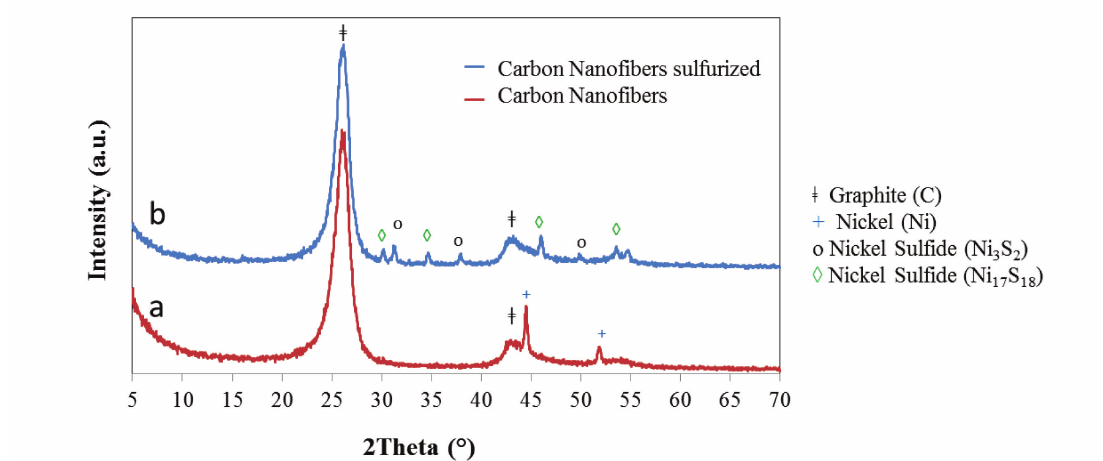
Figure 3. X-ray diffraction pattern of carbon nanofibers. ( a ) Typical peaks of graphite and nickel metal are identified in samples as prepared; ( b ) XRD pattern after sulfurization step shows graphite and nickel sulfide reflections.